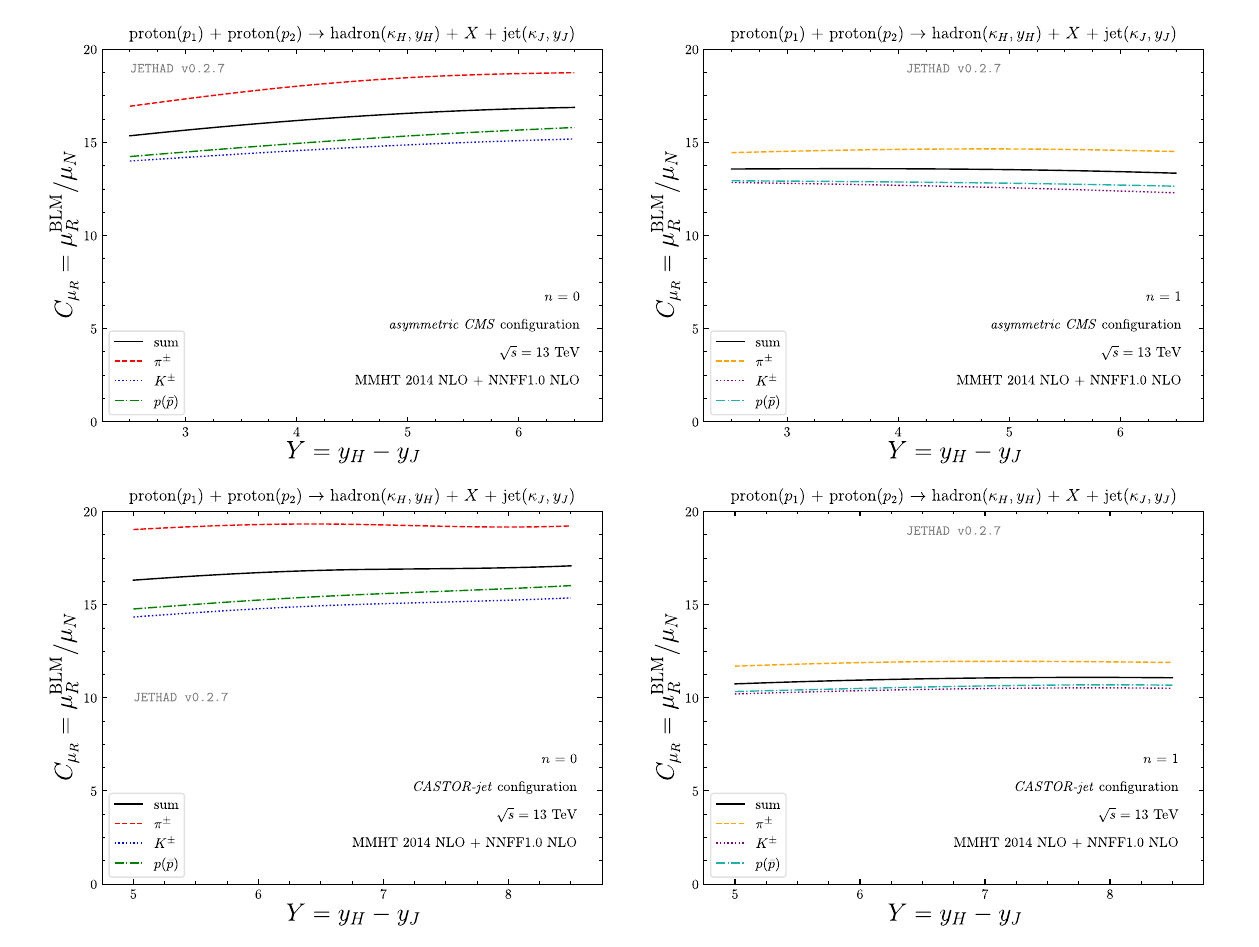
Fig. 8 BLM scales for the inclusive hadron-jet production (central panel in Fig. 2) versus the final-state rapidity interval, Y , for the ϕ - averaged cross section C 0 (left) and the azimuthal coefficient C 1 (right), √ s = 13 TeV in the asymmetric CMS configuration. Predictions for for singlehadron-speciesemissions( π ± , K ± , p ( ¯ p ) )arecomparedwiththe